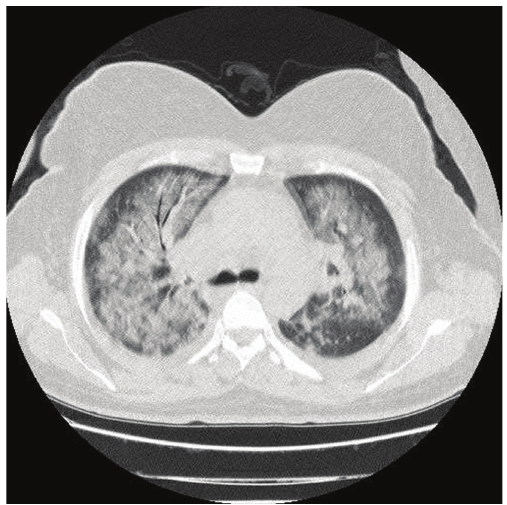
Figure 1: High resolution computed tomography revealed exten- sive ground-glass infiltrates in both lungs.